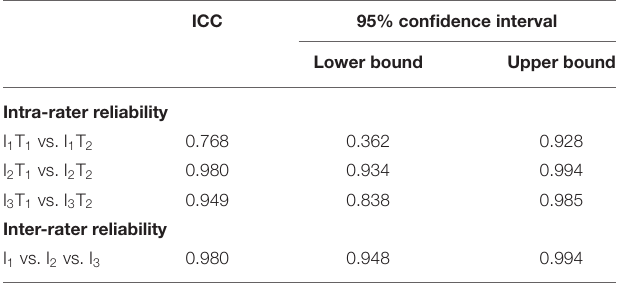
TABLE 2 | Results of the two-way mixed absolute agreement calculation for ICC.